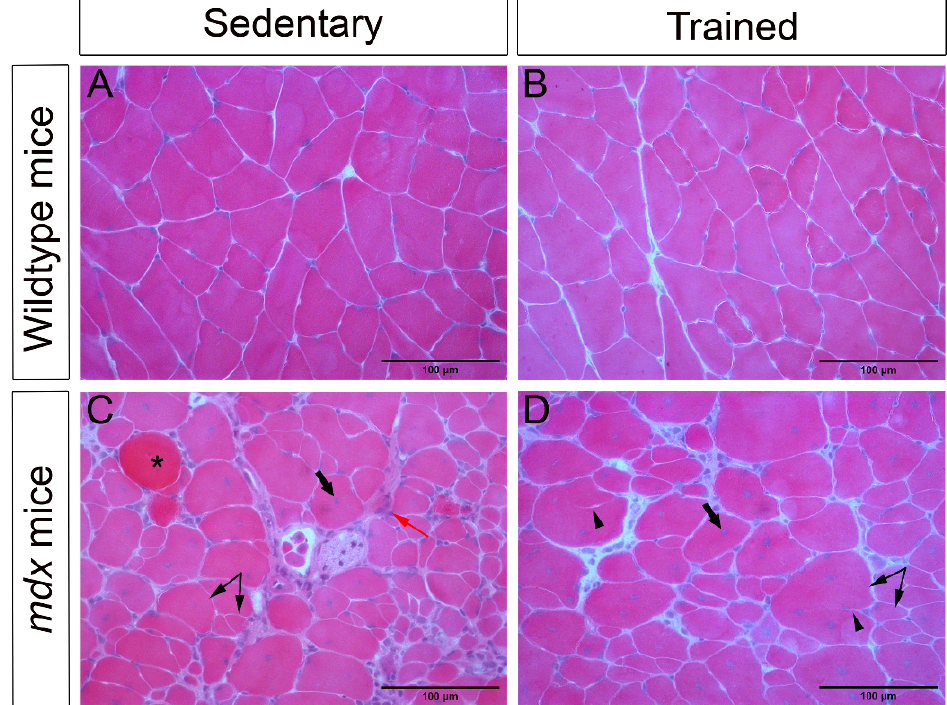
Figure 2. Low-intensity exercise improved the morphological characteristics of the dystrophic muscle. ( A ) Normal cytoarchitecture of the psoas muscle of WT-SED mice. ( B ) Normal cytoarchitecture of the psoas muscle of WT-TR mice. ( C ) Pathological changes in the psoas muscle of mdx -SED mice. ( D ) Exercise improved the tissue cytoarchitecture of mdx -TR mice, although pathological characteristics were still observed. Asterisk: basophilic cell; thick arrow: centralized nucleus; red arrow: necrosis/inflammatory infiltrate; arrowhead: splitting; double arrow: variation in fiber size. Scale bar = 100 µ